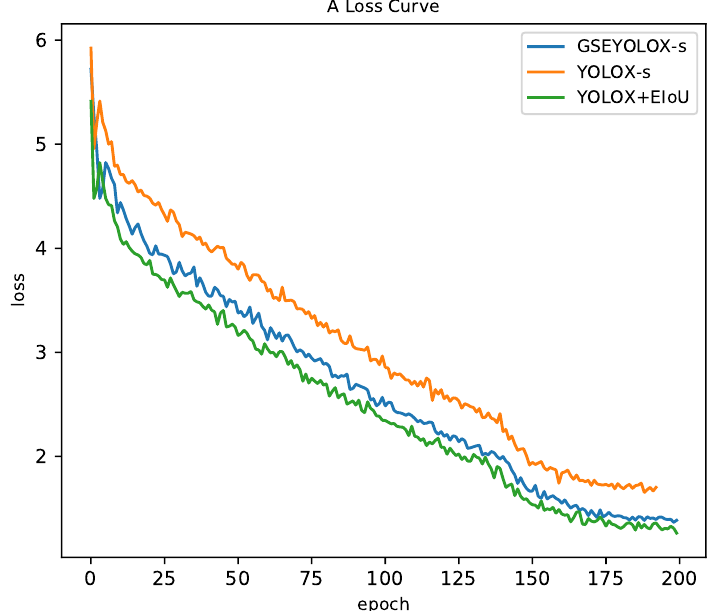
Figure 4. The loss curves during training process.